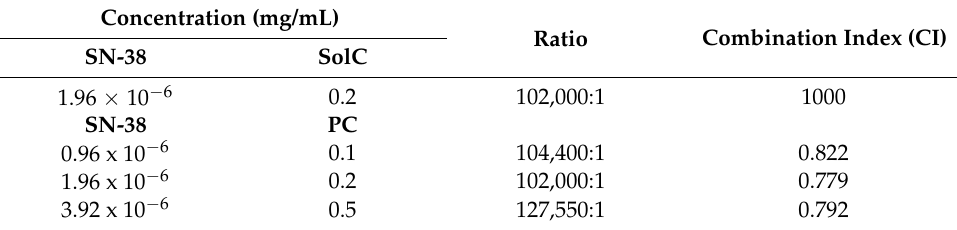
Table 1. Combination of pectins with SN-38 against HCT 116 cell